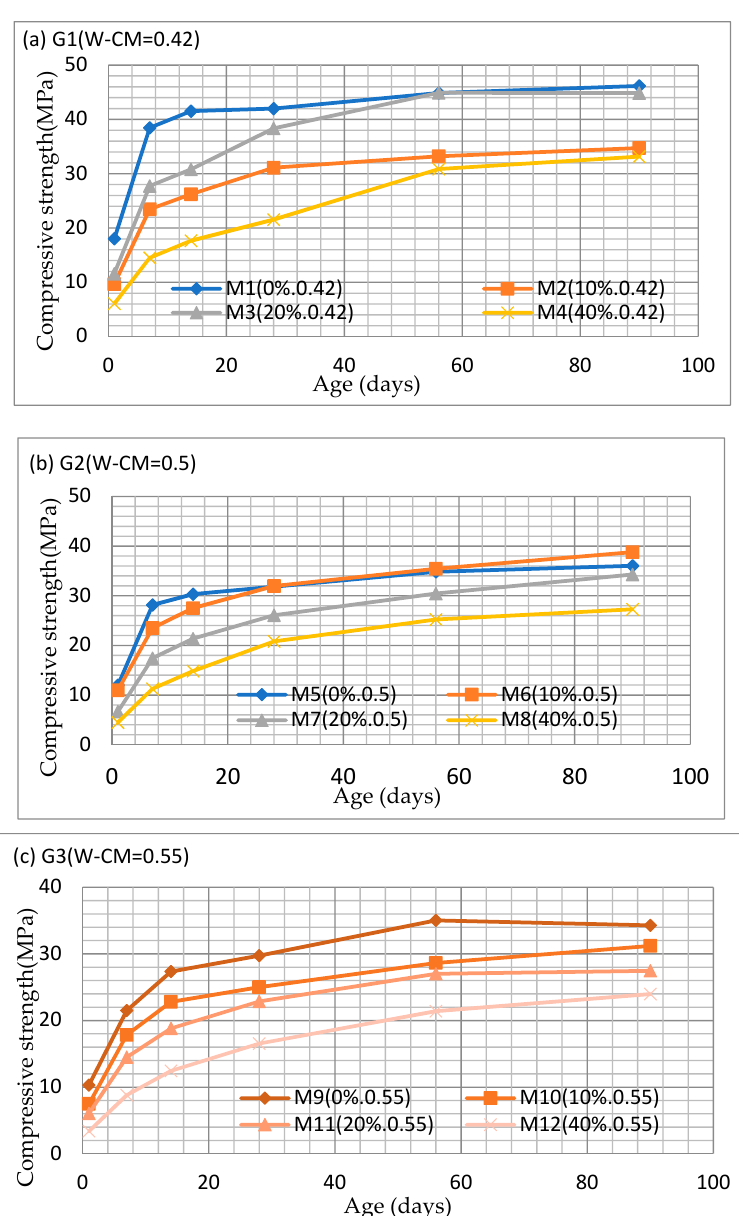
Figure 4. Compressive strengths of concrete specimens ( a ) G1 (W–CM = 0.42); ( b ) G2 (W–CM = 0.50); ( c ) G3 (W–CM = 0.55).